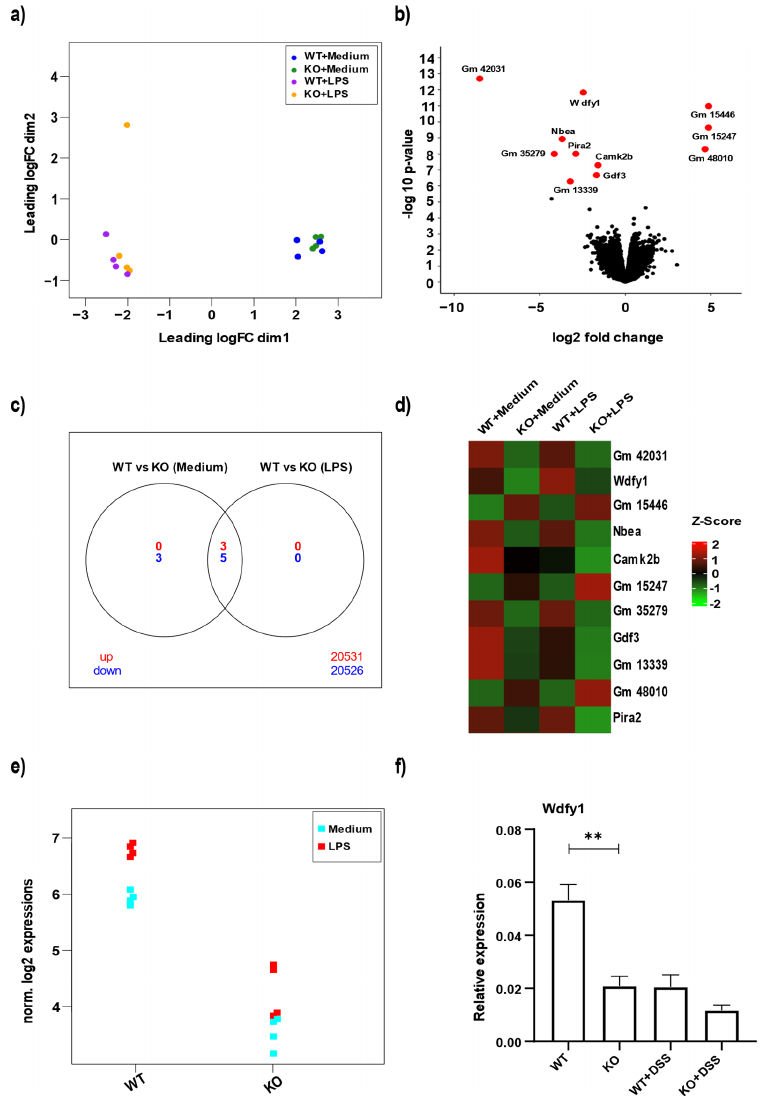
Figure 4. Differential gene expression analysis of miR-511-deficient and wild-type macrophages. Bone marrow-derived M2 macrophages were generated from WT and miR-511-deficient mice. WT and miR-511-deficient groups (KO) with and without LPS stimulation were compared. ( a ) Multidi- mensional scaling plot (MDS) using the top 500 most variable genes between samples to calculate the pairwise distances approximating the typical log2 fold changes between samples. The 16 samples are designated as WT+medium (blue), KO+medium (green), WT+LPS (purple), and KO+LPS (orange). ( b ) Volcano plot comparing WT with miR-511-deficient conditions. Differentially transcribed genes with a − log10 ( p -value) > 6 are indicated with a red dot and annotated by their gene symbol. ( c ) Venn diagram of significant differentially expressed genes, upregulated genes (red) and downregulated genes (blue). A p -value <0.05 corrected for multiple testing using the Benjamini-Hochberg false dis- covery rate is used as a cut-off ( d ) Heatmap of top 11 differentially expressed genes. The mean of the gene expression per condition was used and the values were standardized. ( e ) Wdfy1 transcription levels in WT and miR-511-deficient macrophages with LPS (designated in red) and without LPS stimulation (designated in blue). ( f ) Wdfy1 gene expression in colon homogenates of control (WT, KO) and DSS groups (WT+DSS, KO+DSS), respectively by qPCR. N = WT = 4, KO = 5, WT+DSS = 9, KO+DSS = 10. The mRNA levels were normalized for their reference genes. Individual values are expressed as mean and standard error of mean. Statistical differences were tested by independent t -test, where a p -value of <0.05 was considered to be significant. ** p -value <